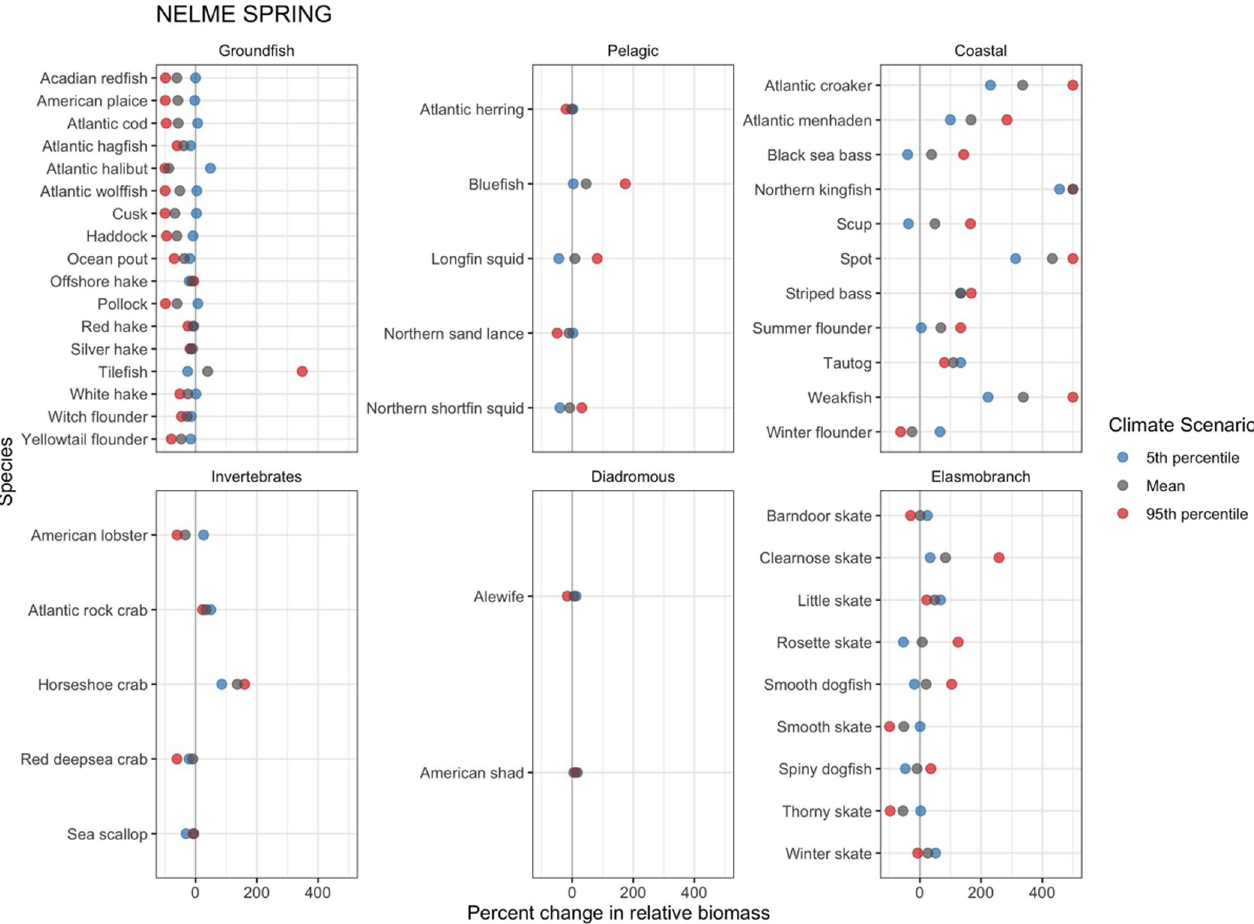
Fig 6. Spring projected shelf-wide percent change in relative species biomass. Projected species relative biomass changes given the 5th percentile, mean, and 95th percentile CMIP5 RCP 8.5 climate model ensemble projected sea surface temperatures. Positive percent increases were capped to 500% for four coastal fish species (Atlantic croaker, Northern kingfish, spot, and weakfish) to facilitate visualizing and comparing changes across species and climate model ensemble projected sea surface temperature